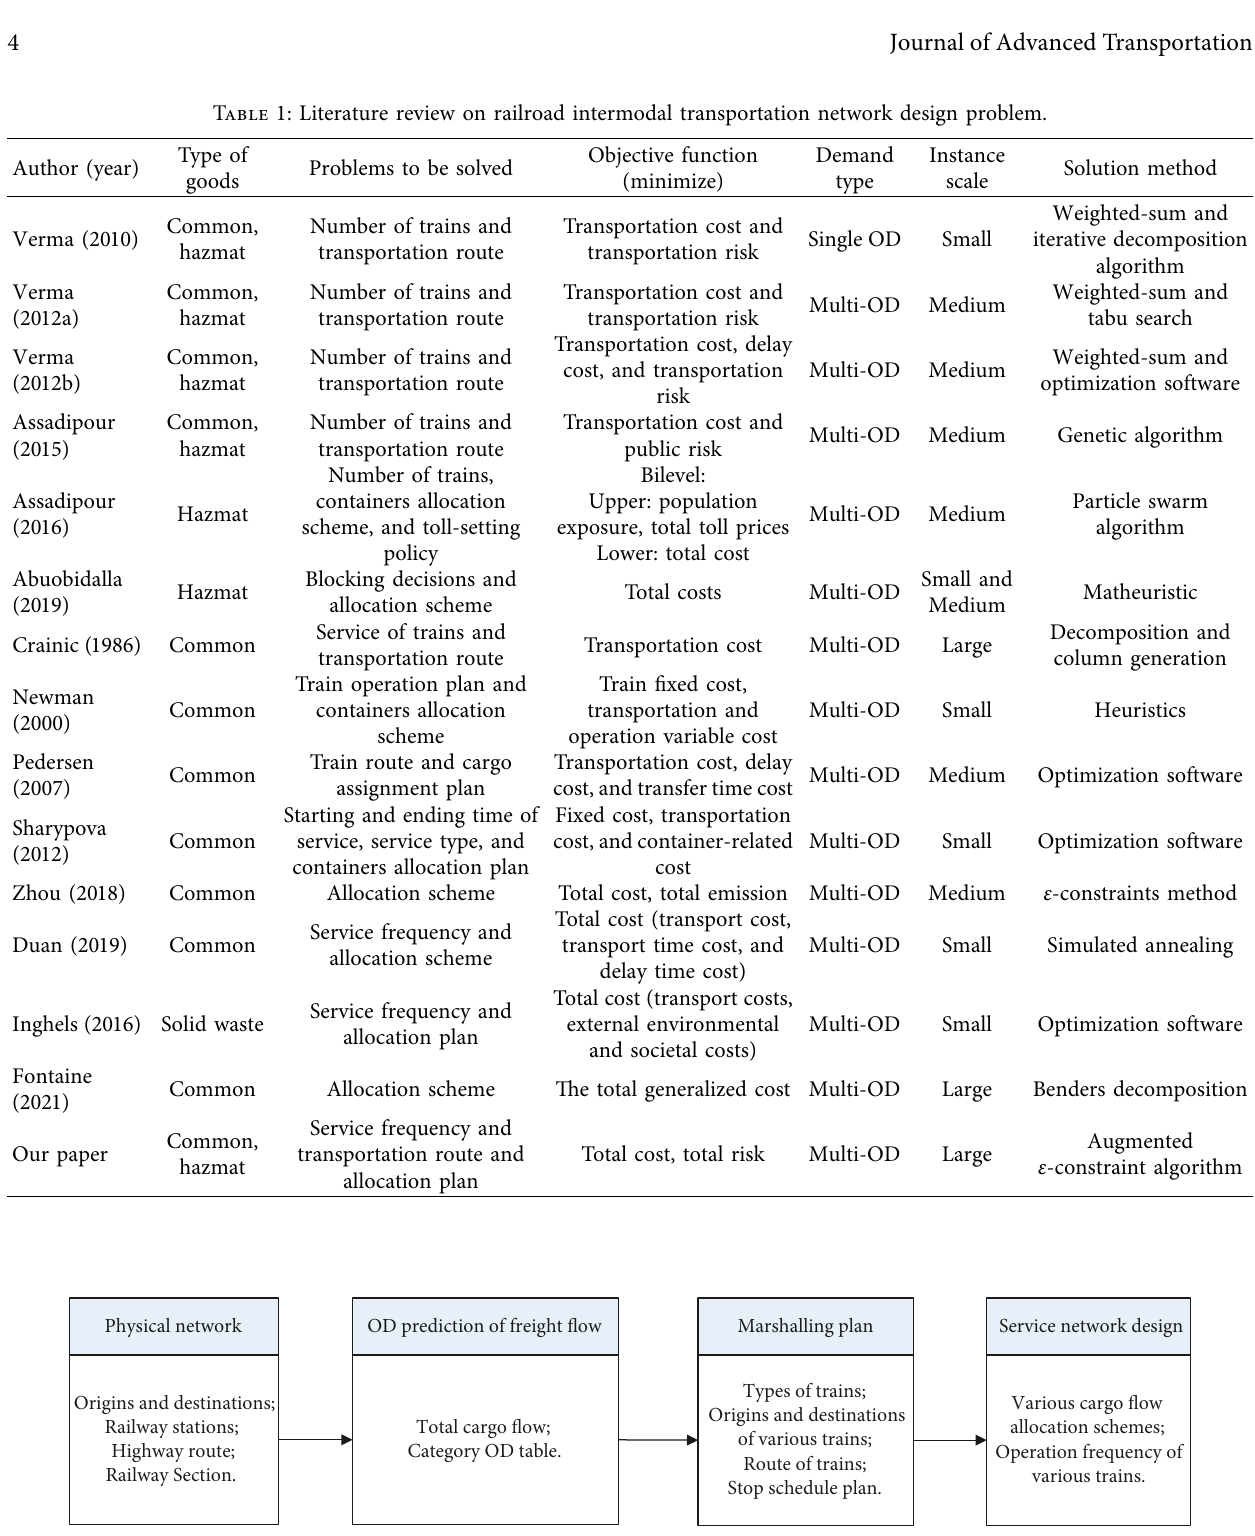
Figure 1: Process of railroad intermodal transportation service network